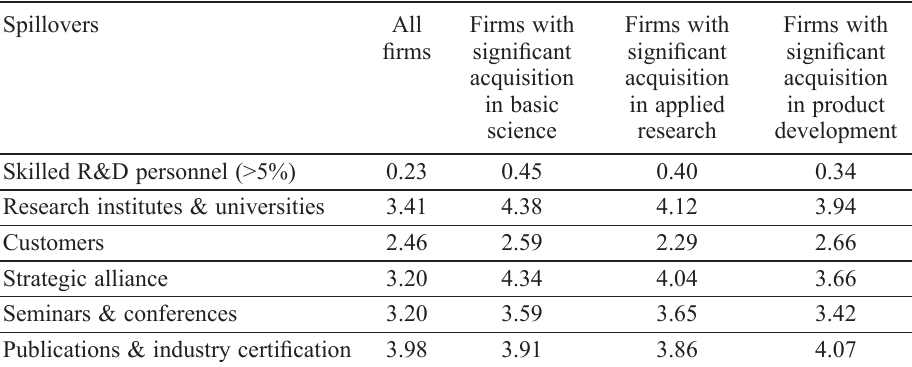
Table 2. International Knowledge Spillovers * : summary statistics